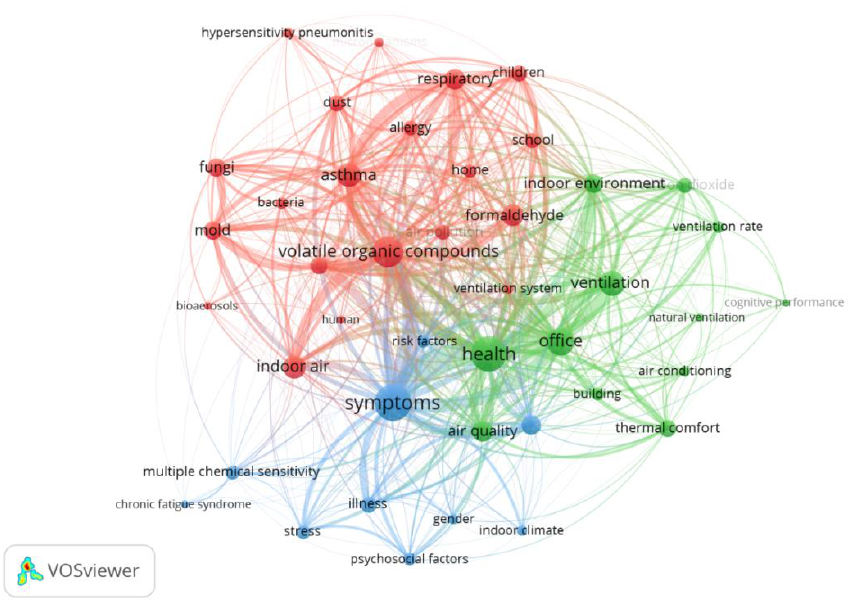
Figure 6. Keywords co-occurrence network of the SBS.